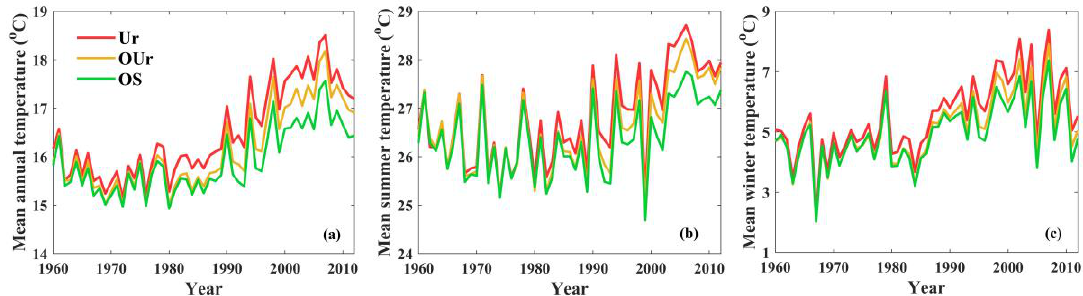
Figure 12. Time series of temperature in Shanghai from 1960 to 2010: ( a ) mean annual temperature; ( b ) mean summer temperature; and ( c ) mean winter temperature.